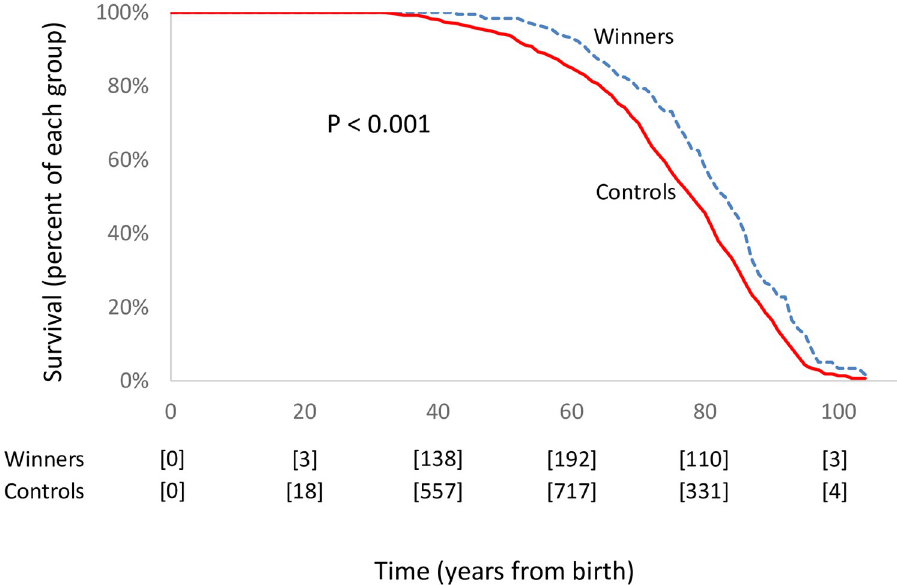
Fig 1. Survival of winners and controls. Survival plot comparing mortality between winners and controls based on multistate model. X-axis denotes time in years following birth. Y-axis denotes percent in each group surviving to corresponding time point. Winners as dashed blue line and controls as solid red line. P-value based on bootstrap statistic. Counts in square brackets indicate number of individuals in risk set at corresponding time point. Results show generally long life-expectancy and significant difference comparing winners to controls. Median survival for winners is 83 years and controls is 78 years.